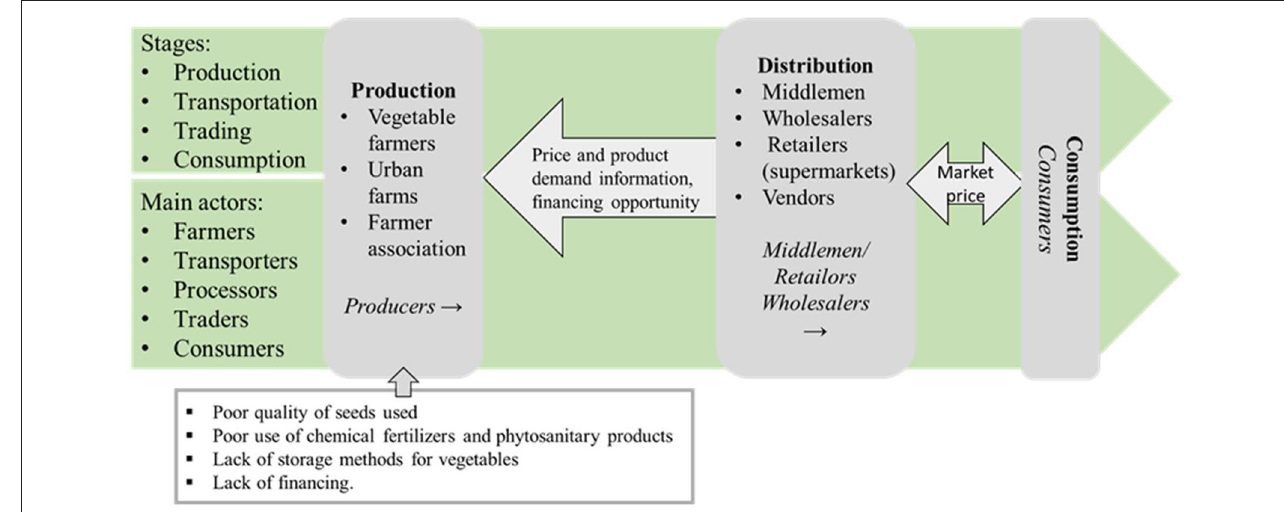
FIGURE 6 | The status quo of LFs and carrot value chains in